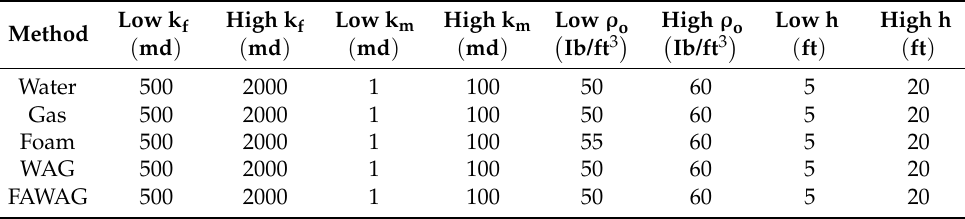
Table 5. Simulation